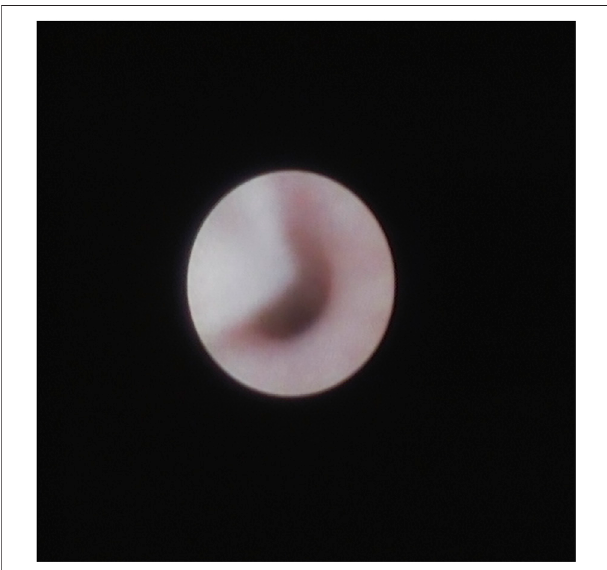
FIGURE 2| Sialendoscopic view: The duct wasstenosisand the mucus plug was in the